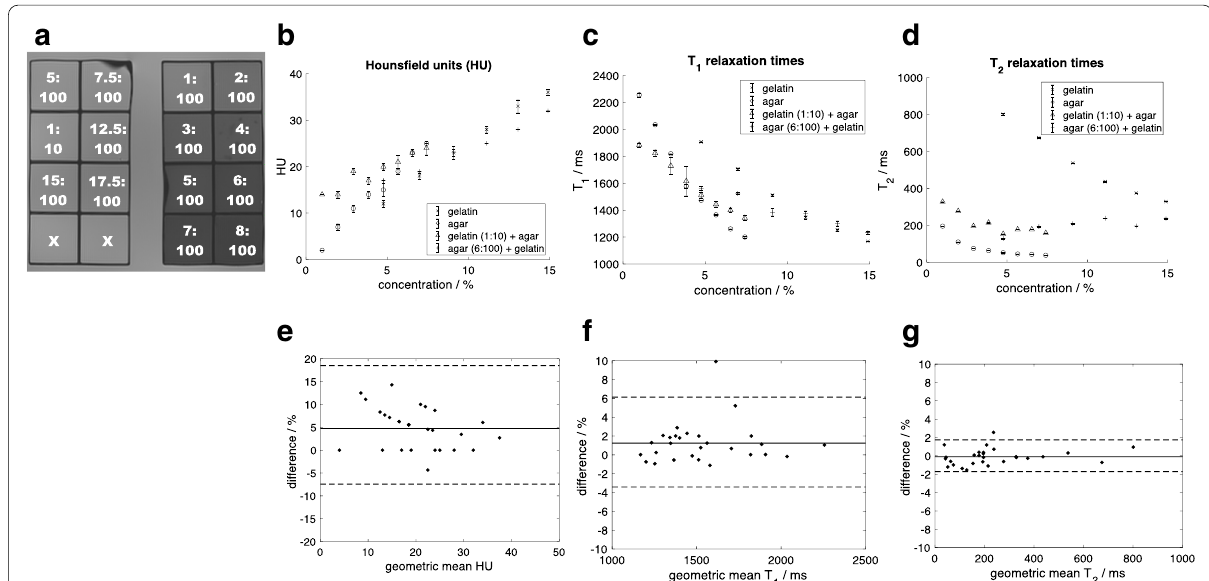
Fig. 5 a Coronal T2‑weighted (echo time 50 ms) magnetic resonance images of pure gelatin (left) and agar (right), trays 1 and 2, showing that gelatin qualitatively returns high signal at all concentrations, whereas agar returns lower signal as concentration increases (the bottom two wells were filled with doped water). Attenuation values (HU) ( b ) T1 ( c ), and T2 ( d ) at different gelatin/agar concentrations. These graphs confirm relatively small differences in HU as the concentration of both substances increases and show that the T2 relaxation time is long in all gelatin samples and short in agar samples. Bland–Altman plots comparing differences between the two test–retest measurements for HU ( e ) T1 ( f ), and T2 ( g ). Solid lines represent the mean difference, and dashed lines the 95% limits of